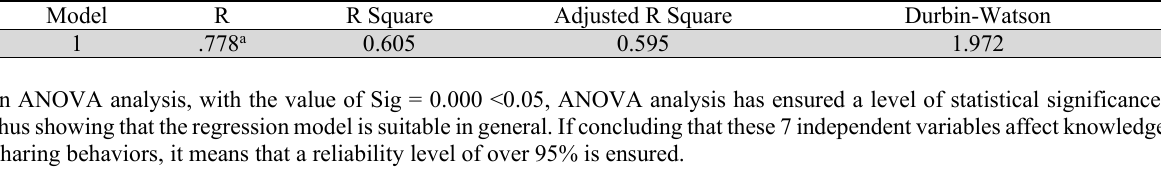
ANOVA analysis results